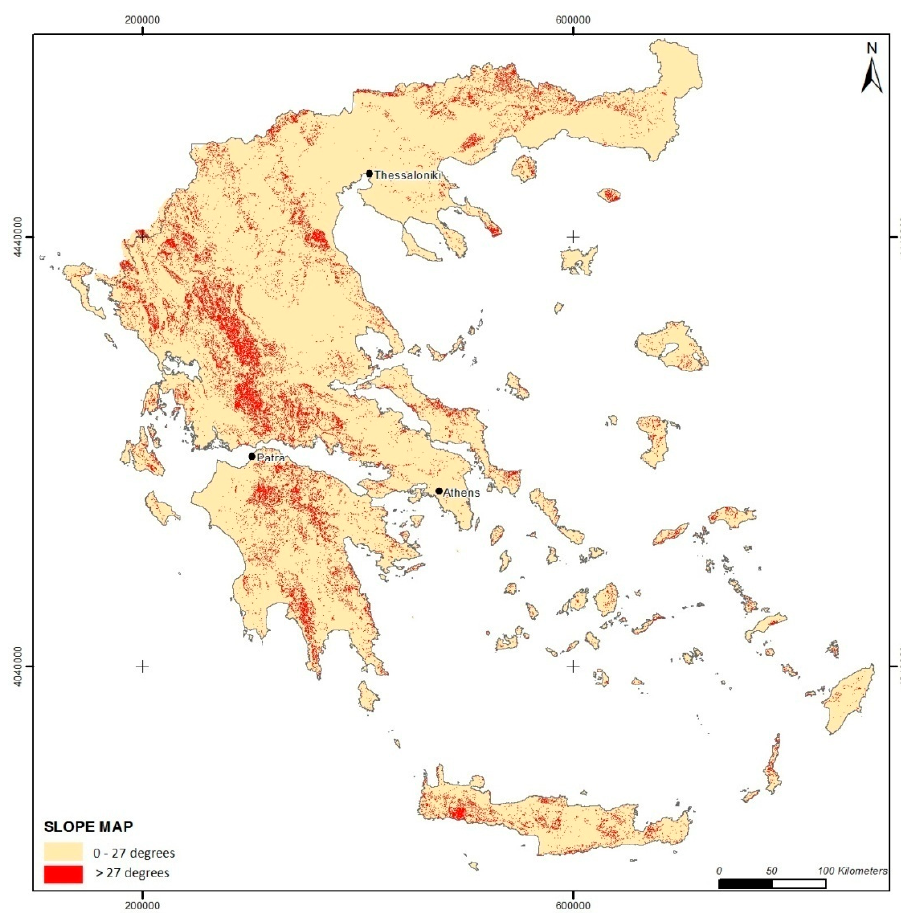
Figure 6. Slope map of Greece.